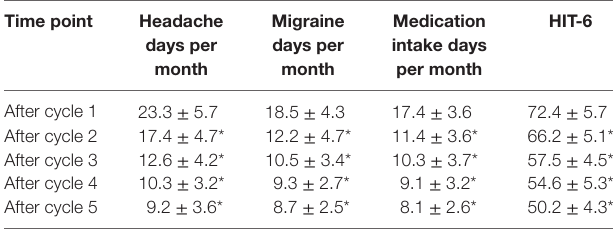
TaBle 2 | Variations in outcome measures referred to the OnabotA